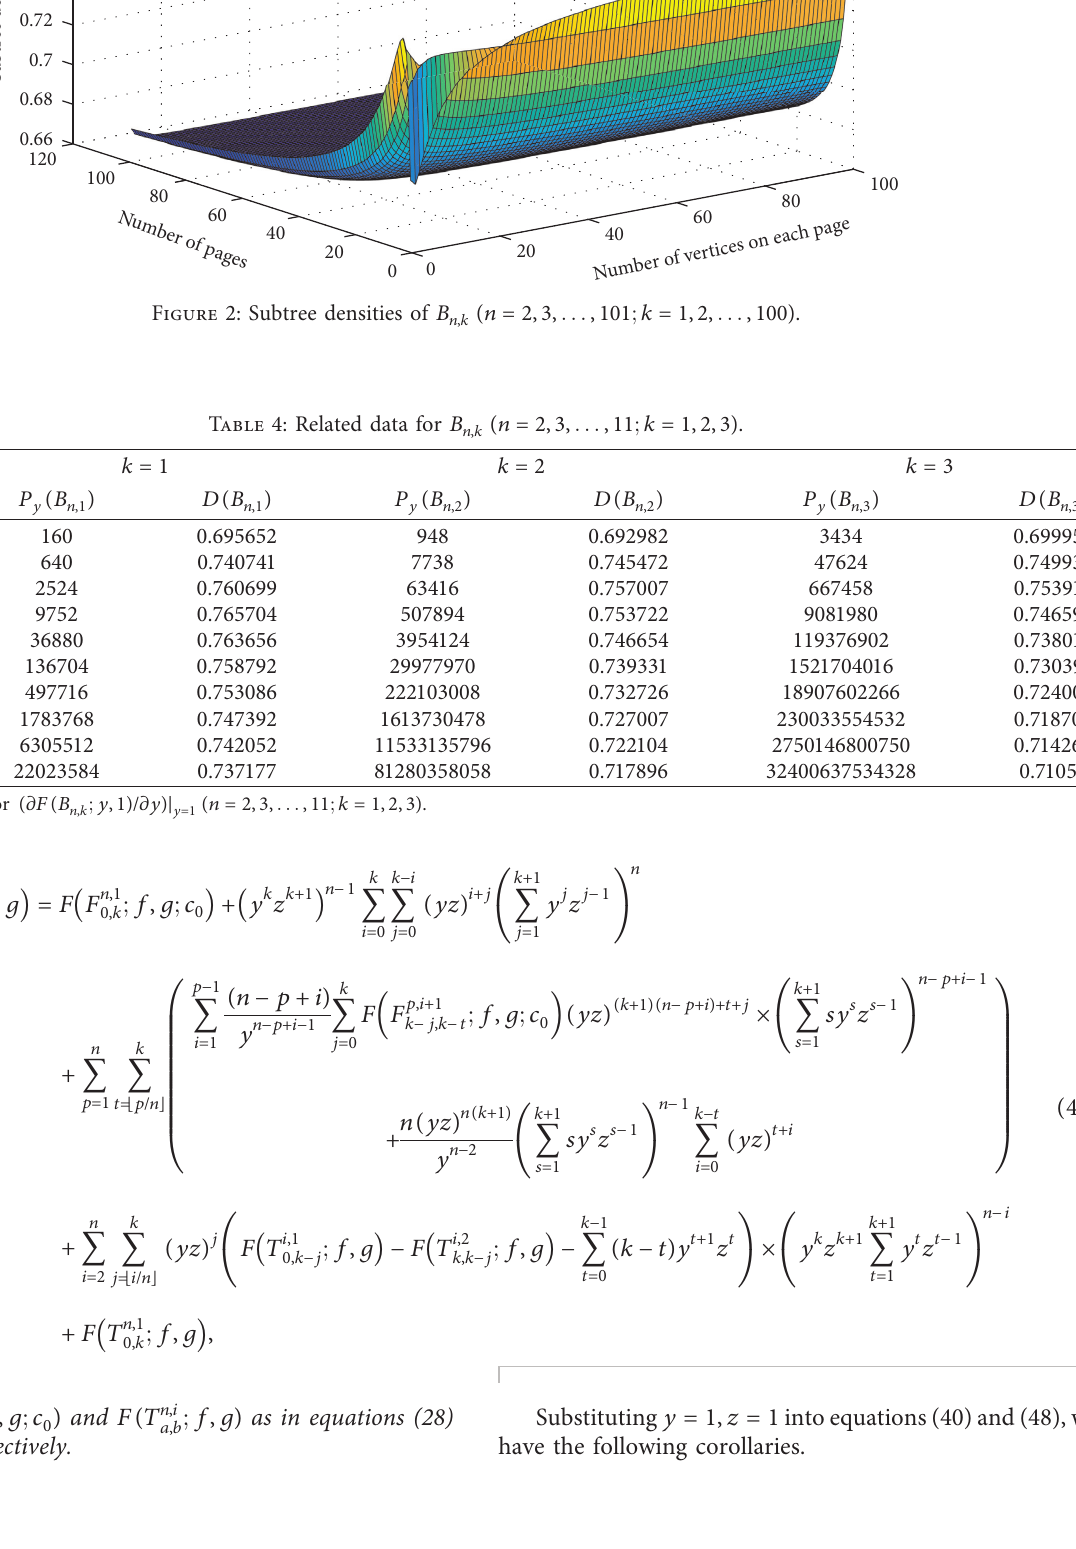
Figure 2: Subtree densities of B